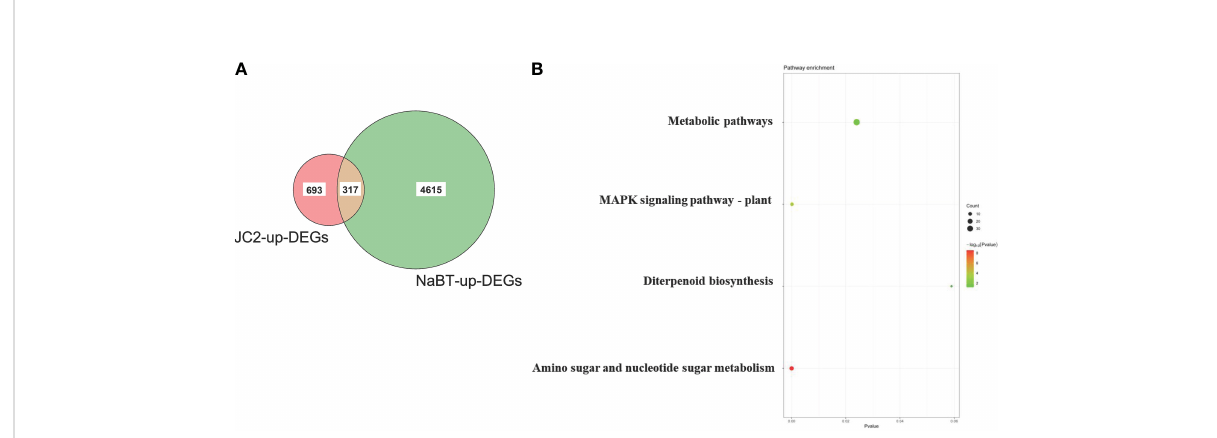
FIGURE 3 Identi fi cation of genes induced by both rice blast infection and NaBT treatment. (A) The number of genes induced by rice blast infection (JC2) and NaBT treatment is presented by venn diagram. (B) The Kyoto Encyclopedia of Genes and Genomes (KEGG) analysis of 317 up-DEGs identi fi ed in (A)